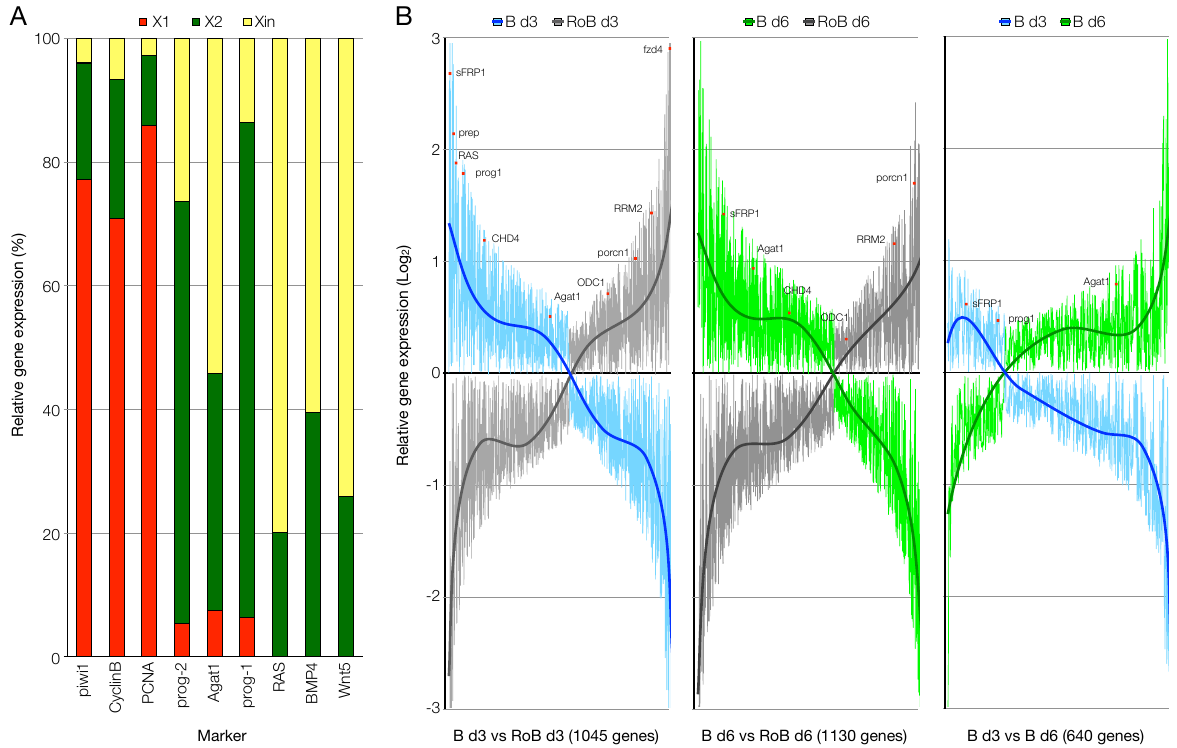
Figure 2. RNA-seq data relative to the expression of known genes. ( A ) Relative expression of genes representative of the FACS cell fractions in X1, X2, and Xin RNA-seq samples. ( B ) Genes differentially expressed between anterior blastema ( B ) and the respective non-regenerating rest of the body (RoB) at day 3 (left panel) and day 6 (center panel) of regeneration or between anterior blastema day 3 and anterior blastema day 6 (right panel), represented as butterfly charts. The position of some representative genes is provided (red dots). A threshold of 1.5-folds was applied, the trendlines represent the ratio of the expression of the genes considered between the pairs of samples